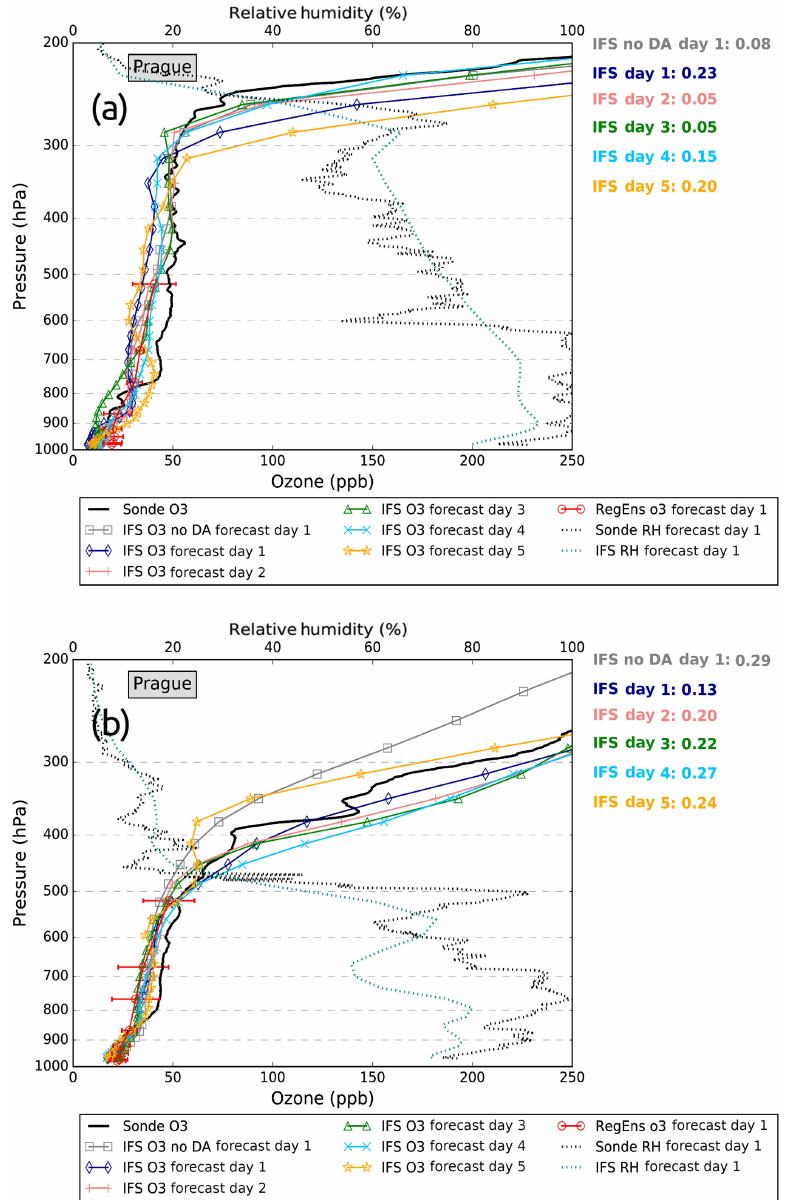
Figure 10. Vertical profiles of ozone mixing ratio (ppb) over Prague, Czech Republic (14.44 ◦ E, 50 ◦ N), for ozonesondes (black line), IFS forecast day 1 (dark blue line), IFS forecast day 2 (coral line), IFS forecast day 3 (green line), IFS forecast day 4 (light blue line), IFS forecast day 5 (orange line), IFS no DA (without data assimilation) forecast day 1 (grey line) and RegEns (red line) at (a) 11:00Z on 2 January 2017 and (b) 11:00Z on 4 January 2017. Also shown are sonde (black dashed line) and IFS forecast day 1 relative humidity (cyan dashed line). The red bars denote the standard deviation among the regional ensemble members. The numbers on the right of the diagrams show the FGE values of IFS ozone (with the corresponding colour) at